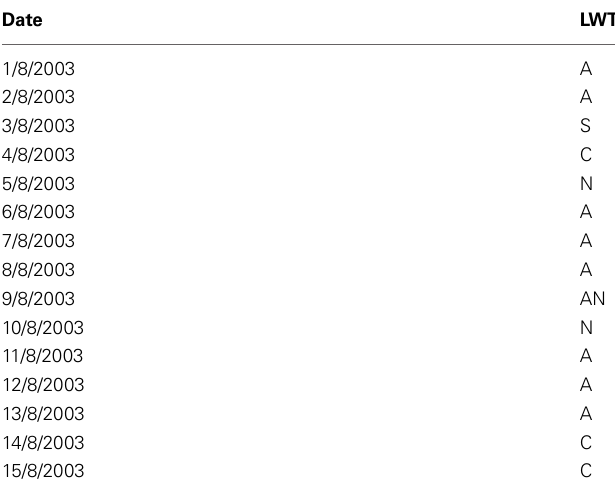
Table 3 | Lamb weather types for each day of the (a) heatwave case study (1/8/2003 to